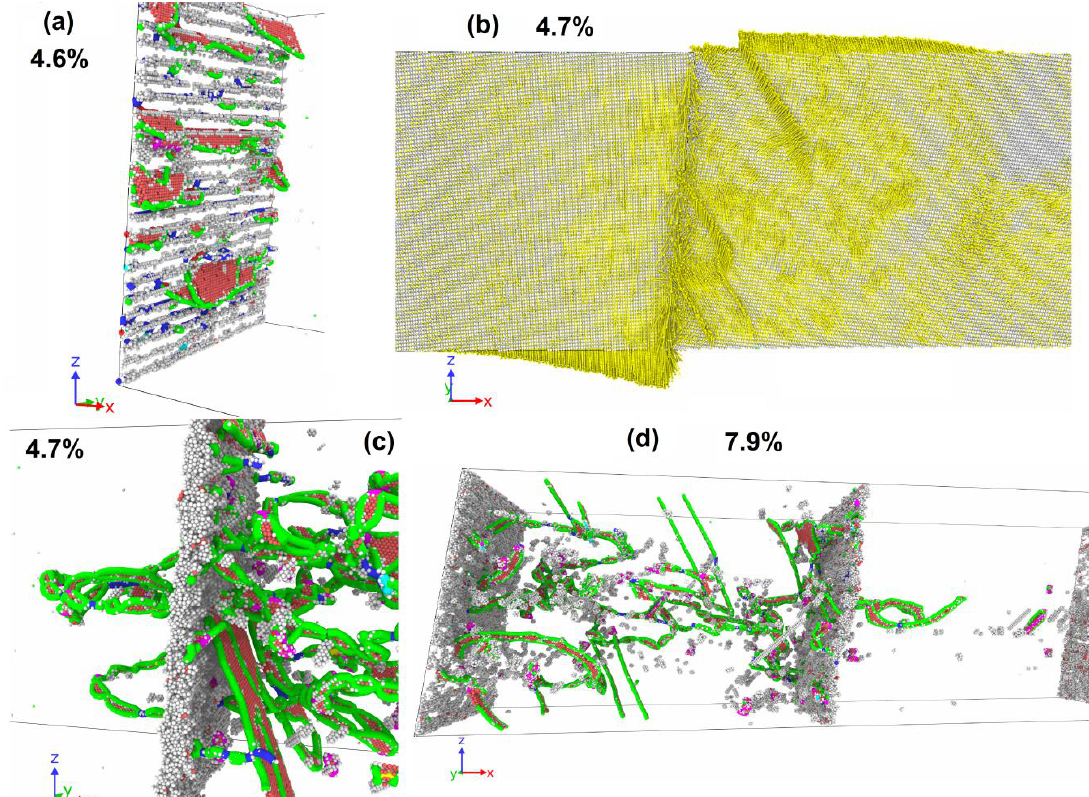
Figure 10. Deformation of system with 87.5% filling of three columns by Cu atoms (14.09 nm − 2 ). ( a ) Emission of dislocations from GB into a grain. Only atoms with central symmetrical parameter exceeding 5 are shown. Grey dots are FCC-type atoms, red — HCP. ( b ) Displacement vectors of atoms (yellow); in the left part of the panel, the displacements have a vertical component directed downwards, in the right part, it is directed upwards, and the vertical displacements discontinuity is located between them. Traces of intragranular dislocation slip are visible, expressed as a discontinuity in both atom vertical and horizontal displacements. ( c ) Formation of a disordered layer at GB, which acts as a source of new dislocations. ( d ) Intragranular dislocation multiplication and emission from clusters of defect atoms in the left grain, emission of dislocations from GB into the right grain. Dislocation structure is determined by DXA: blue lines are perfect dislocations, green — Shockley partials, light blue — Frank partials, purple — stair rod segments.